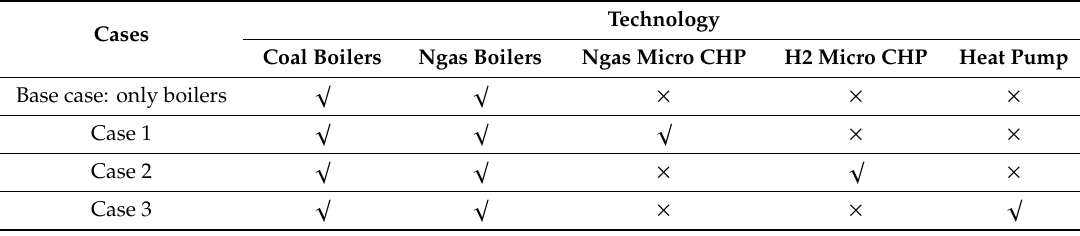
Table 2. Summary of Di ff erent Cases of Individual Heating